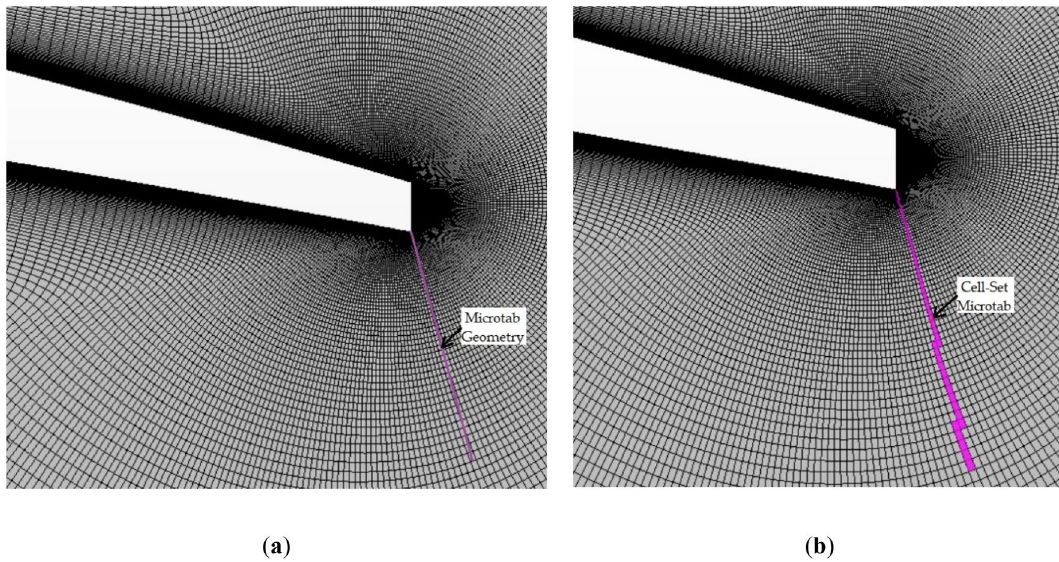
Figure 3. Cell-set implementation for modelling a microtab: ( a ) geometry of the microtab; ( b ) microtab generated using the cell-set model.